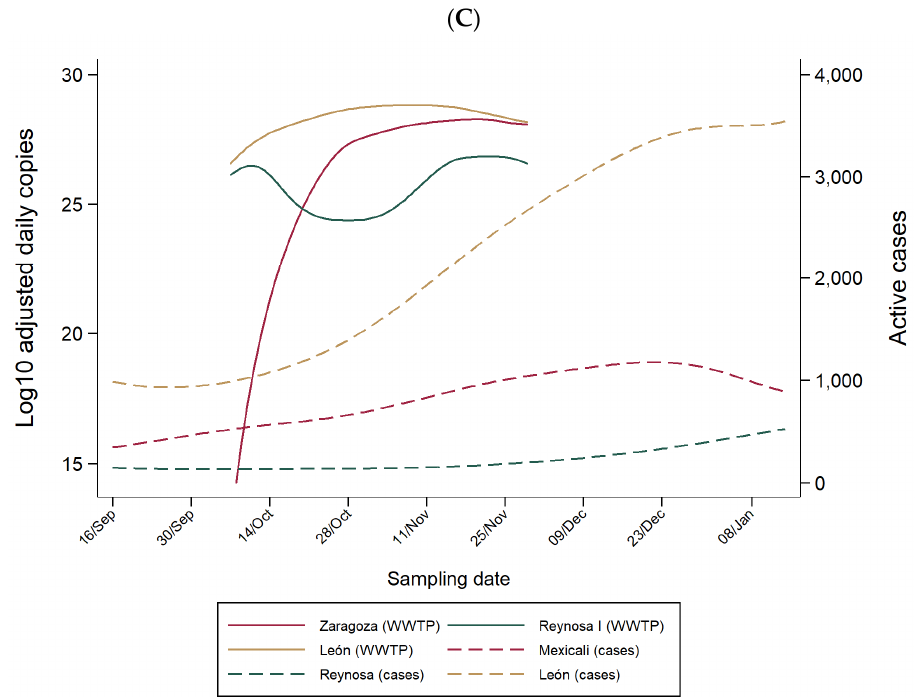
Figure 3. Adjusted Log10 SARS-CoV-2 RNA daily load and active cases temporal trend by WWTP, Mexico, October–November 2020. ( A ) Large WWTP; ( B ) Medium WWTP; ( C ) Small WWTP. Table 2. Correlation coefficients (Rho) and corresponding lead time days for WW SARS-CoV-2 RNA load compared to the clinical surveillance metric (active cases) by site, Mexico,